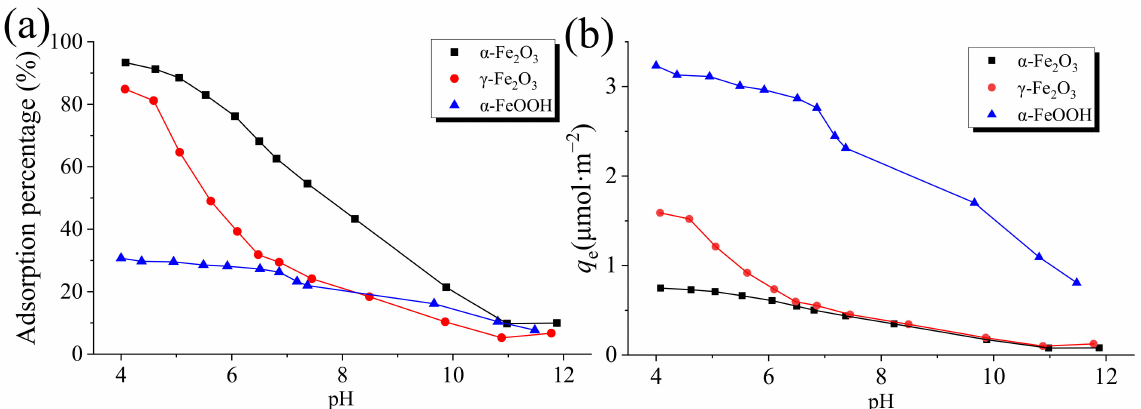
Figure 3. Effect of pH on ASA adsorption on iron oxides. ( a ) Data shown as adsorption percentage (%) and ( b ) data shown as adScheme 2. Solid points are experimental data; polylines are for the visual guide. ASA = 20 µ M, iron oxdies = 0.2 g · L − 1 , and NaCl = 10